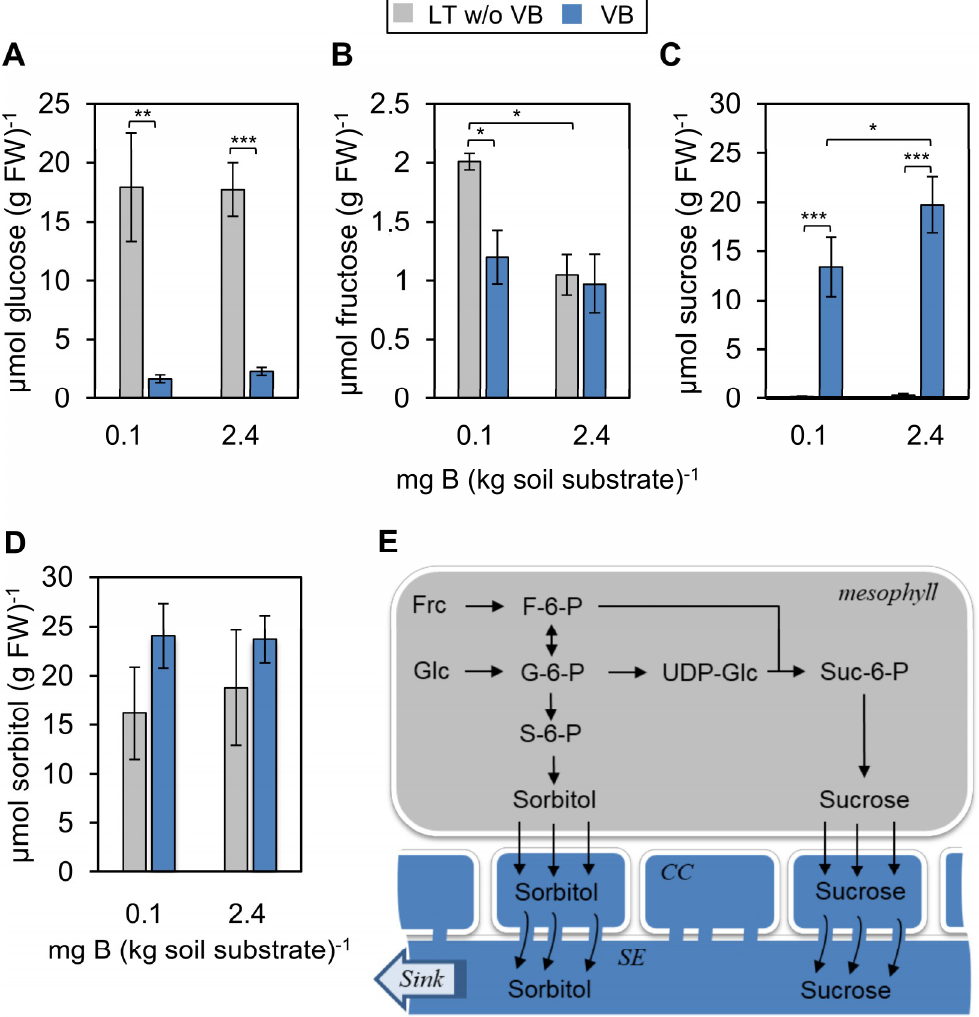
Figure 2. Quantification of sugars in vascular bundles (VB; blue bar charts) and leaf tissue without vascular bundles (LT w/o VB; grey bar charts) in P. major plants grown on two different soil B conditions. ( A ) The concentration of glucose, ( B ) fructose, ( C ) sucrose, and ( D ) the sugar alcohol sorbitol. Bars represent means of at least n = 6 samples ± SD. Asterisks represent p -values < 0.05 (*), < 0.01 (**), < 0.001 (***) according to double-sided t -test. ( E ) Schematic depiction of P. major phloem loading and the biosynthesis of the analyzed sugars. Sugars are synthesized in the mesophyll tissue and the transport forms of sugars, which are sorbitol and sucrose, are loaded via specific transporters into companion cells (CC) from where they travel symplasmically into phloem sieve elements (SE) and along with the phloem stream into sink organs. Abbreviations: Frc = fructose, Glc = glucose, G-6-P = Glc-6-Phosphate, F-6-P = Frc-6-Phosphate, S-6-P = Sorbitol-6-Phosphate, Suc-6-P =